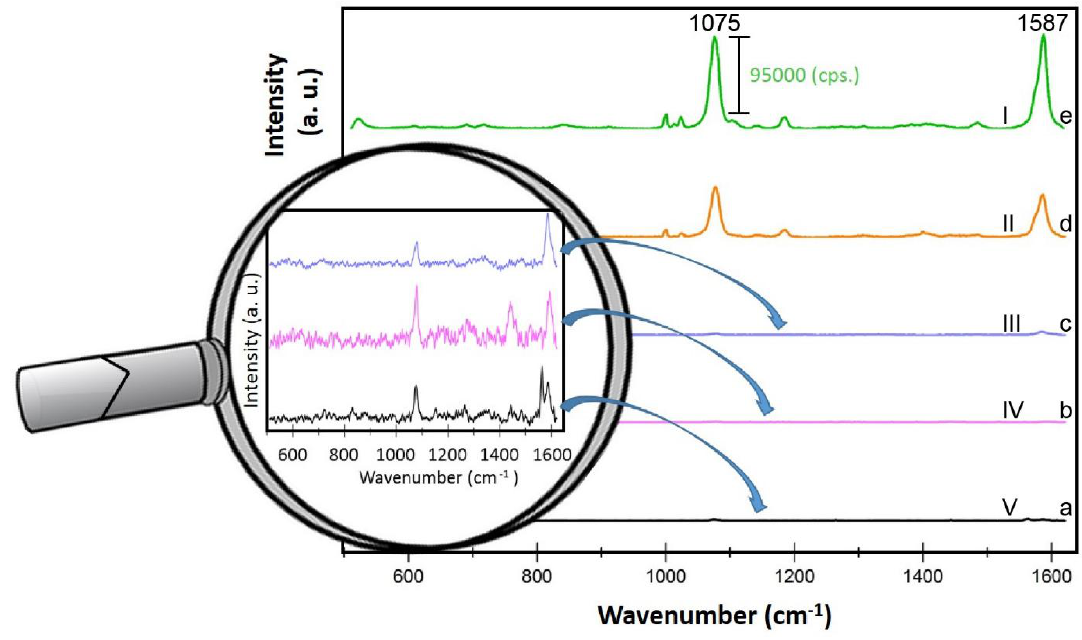
Figure 5. SERS spectra of p -MBA recorded from five different SERS substrates (a-e) with varying morphology of wire mesh (according to parameters described in Table 1). Experimental conditions: 5 mW of 785 nm excitation, 2 × 5 seconds acquisition time. The image in magnifier presents the close view of the region with marker band at 1075 cm −1 for SSWM surfaces showing low EF. Each SERS spectrum was averaged from twenty measurements in different places of SERS surface. Table 2. The EF factors for five different Ag/SSWM substrates (Table 1).